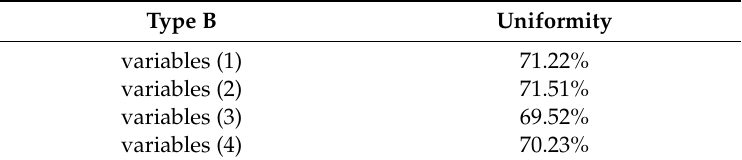
Table 4. Uniformity of type B simulation results.